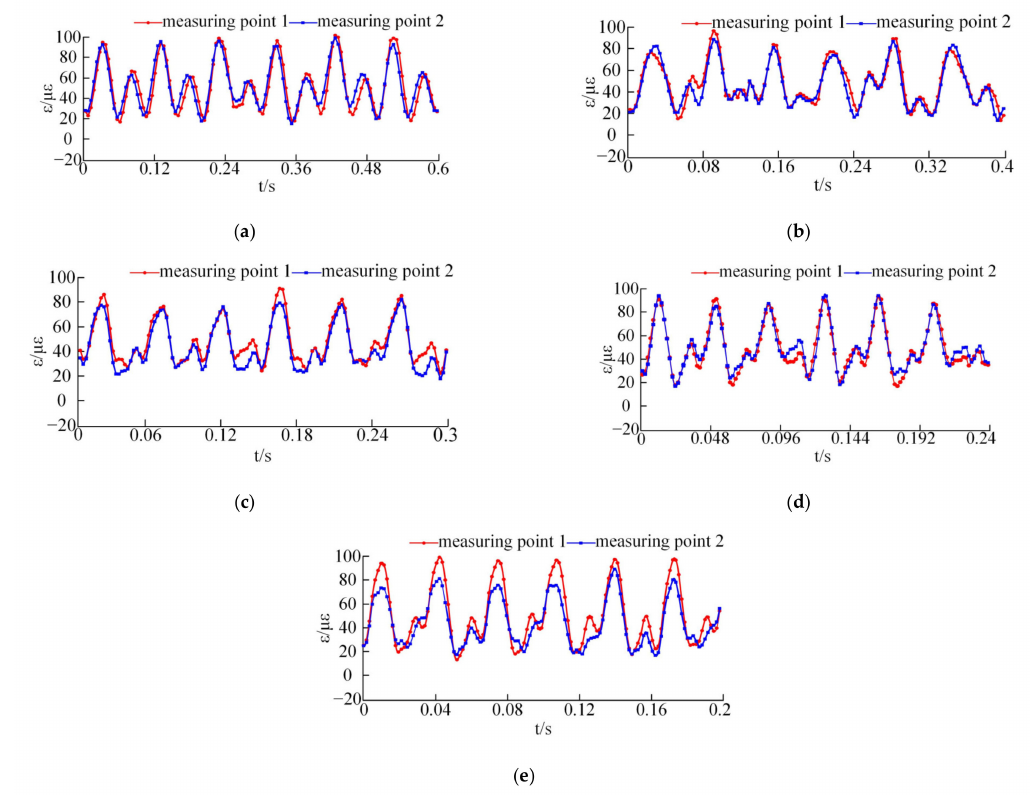
Figure 17. Strain curves under different input speeds: ( a ) 400 r/min; ( b ) 600 r/min; ( c ) 800 r/min; ( d ) 1000 r/min; ( e ) 1200